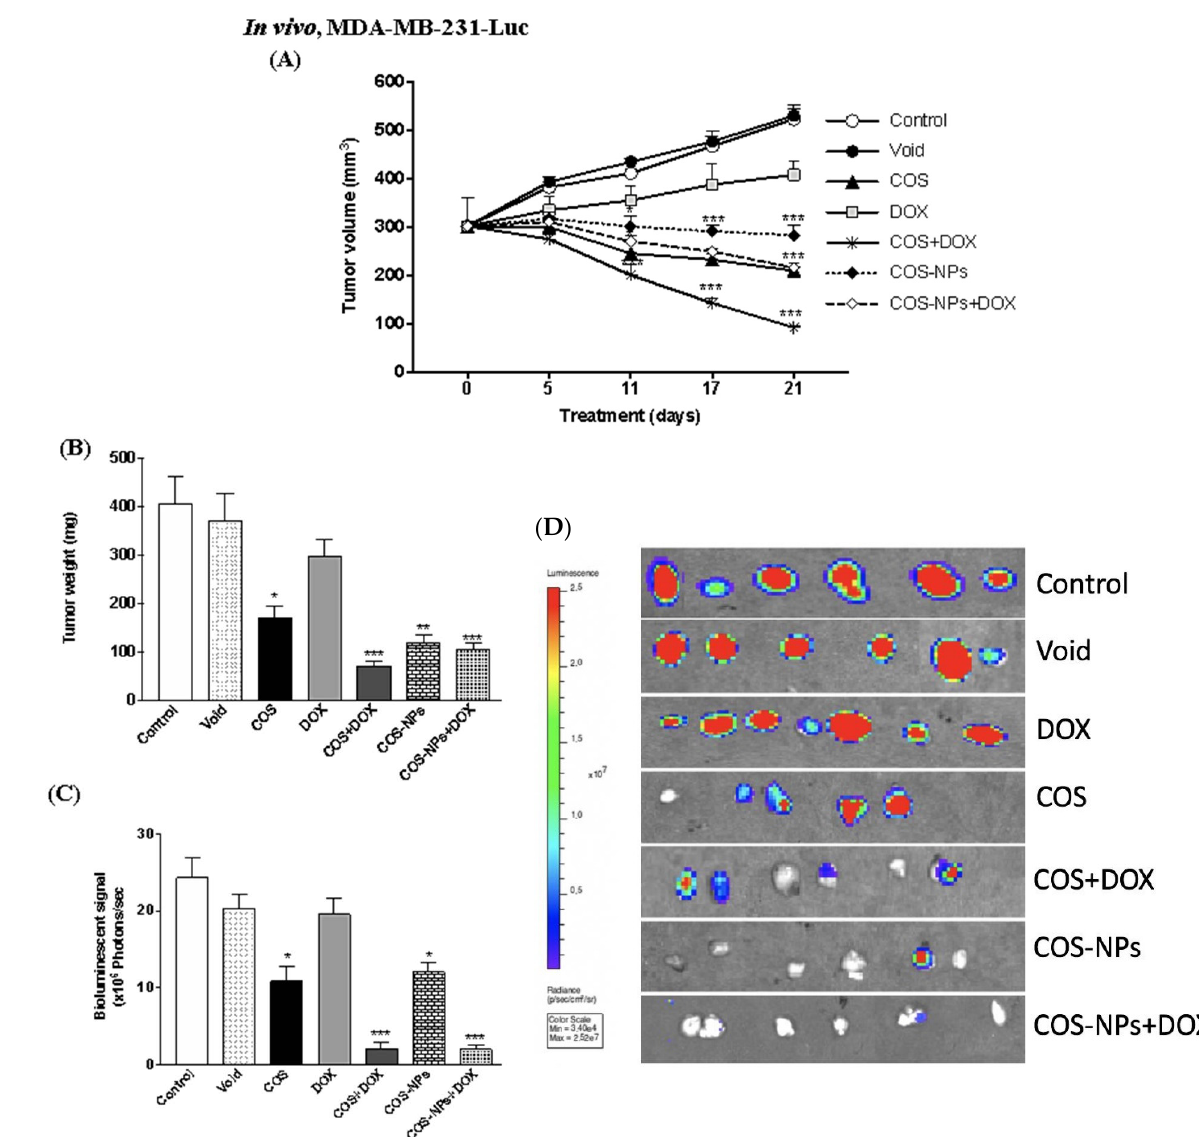
Figure 8. Tumor growth after 21 days in nude mice implanted with MDA-MB-231-Luc cell lines treated with costunolide (COS), doxorubicin (DOX), costunolide + doxorubicin (COS + DOX), costunolide-nanoparticles (COS-NPs), and costunolide- nanoparticles + doxorubicin (COS-NPs + DOX). ( A ) Tumor volumes ( B ) Tumor weight. ( C , D ) Bioluminescence signals. Values are presented as mean ± SD. * p < 0.05, ** p < 0.01, and *** p <